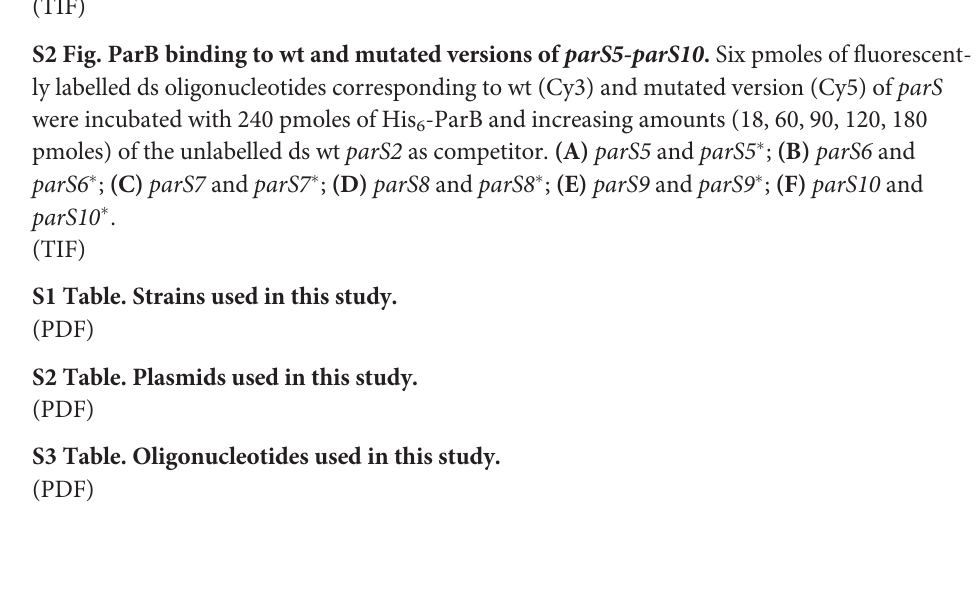
pmoles of 5 ’ Cy3-labelled parS2 oligonucleotide (annealed oligonucleotides #3 and #4, S3 -ParB (0, 40, 80, 100 pmoles) in 20 μ l of binding buffer. Table) and increasing amounts of His 6 Cy5-labelled nonspecific oligonucleotide (annealed oligonucleotides #35 and #36) was used as a control. After incubation at 37°C for 15 min, the complexes were separated on a native 5% polyacrylamide gel in TBE buffer, the DNA was visualized with FluorChemQ MultiImageIII ChemiImager and the images were captured using AlphaView software (Alpha Innotech). S2 Fig. ParB binding to wt and mutated versions of parS5-parS10 . Six pmoles of fluorescent- ly labelled ds oligonucleotides corresponding to wt (Cy3) and mutated version (Cy5) of parS -ParB and increasing amounts (18, 60, 90, 120, 180 were incubated with 240 pmoles of His 6 pmoles) of the unlabelled ds wt parS2 as competitor. (A) parS5 and parS5 (cid:1) ; (B) parS6 and parS6 (cid:1) ; (C) parS7 and parS7 (cid:1) ; (D) parS8 and parS8 (cid:1) ; (E) parS9 and parS9 (cid:1) ; (F) parS10